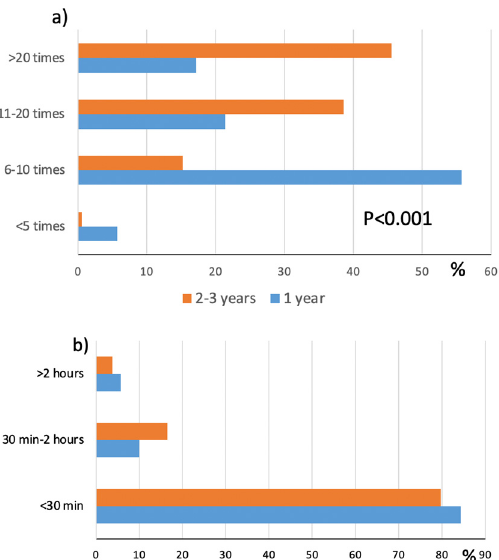
Figure 2. Distribution of hand washing per day ( a ) and wet time ( b ) in 1st-year and 2nd–3rd–year students.